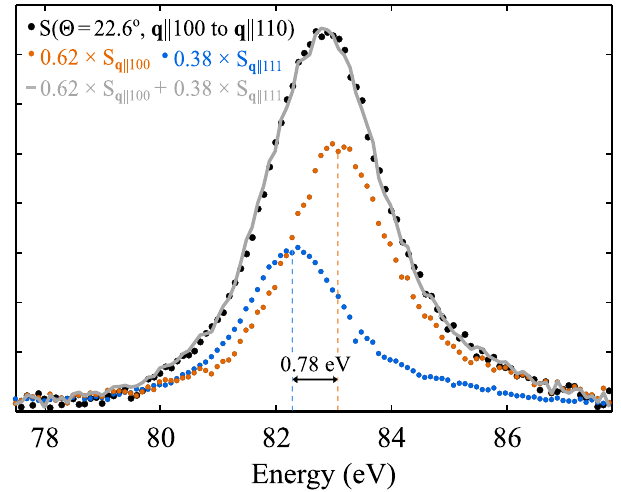
FIG. 4. The experimental spectrum for a given angle Θ (black dots) is decomposed using the weighted sum of S q k½ 111 (cid:2) (blue dots) and S q k½ 100 (cid:2) (orange dots) spectra that provides the best fit (gray